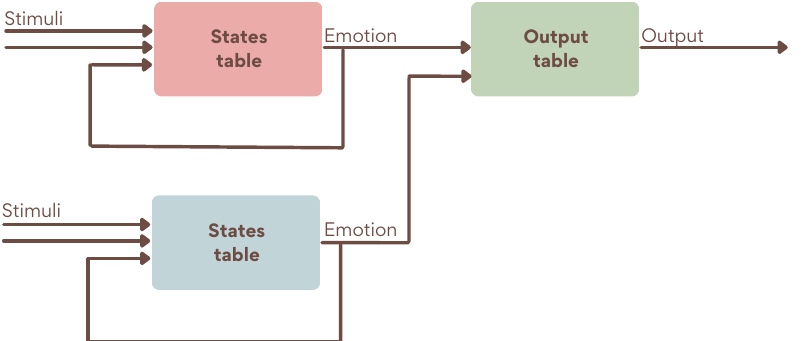
Figure 6. Schematic representation of a simplified version of the emotional state model with two